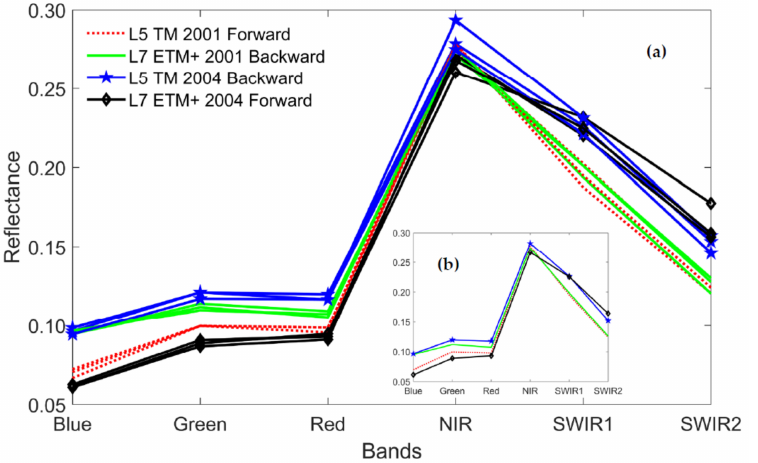
Figure 7. Multi-band reflectance over three sites extracted from two pairs of adjacent TM/ETM+ images in 2001 and 2004 at six spectral bands from individual sites shown in the major plot ( a ) and the mean of each compared day in the lower embedded plot ( b ).